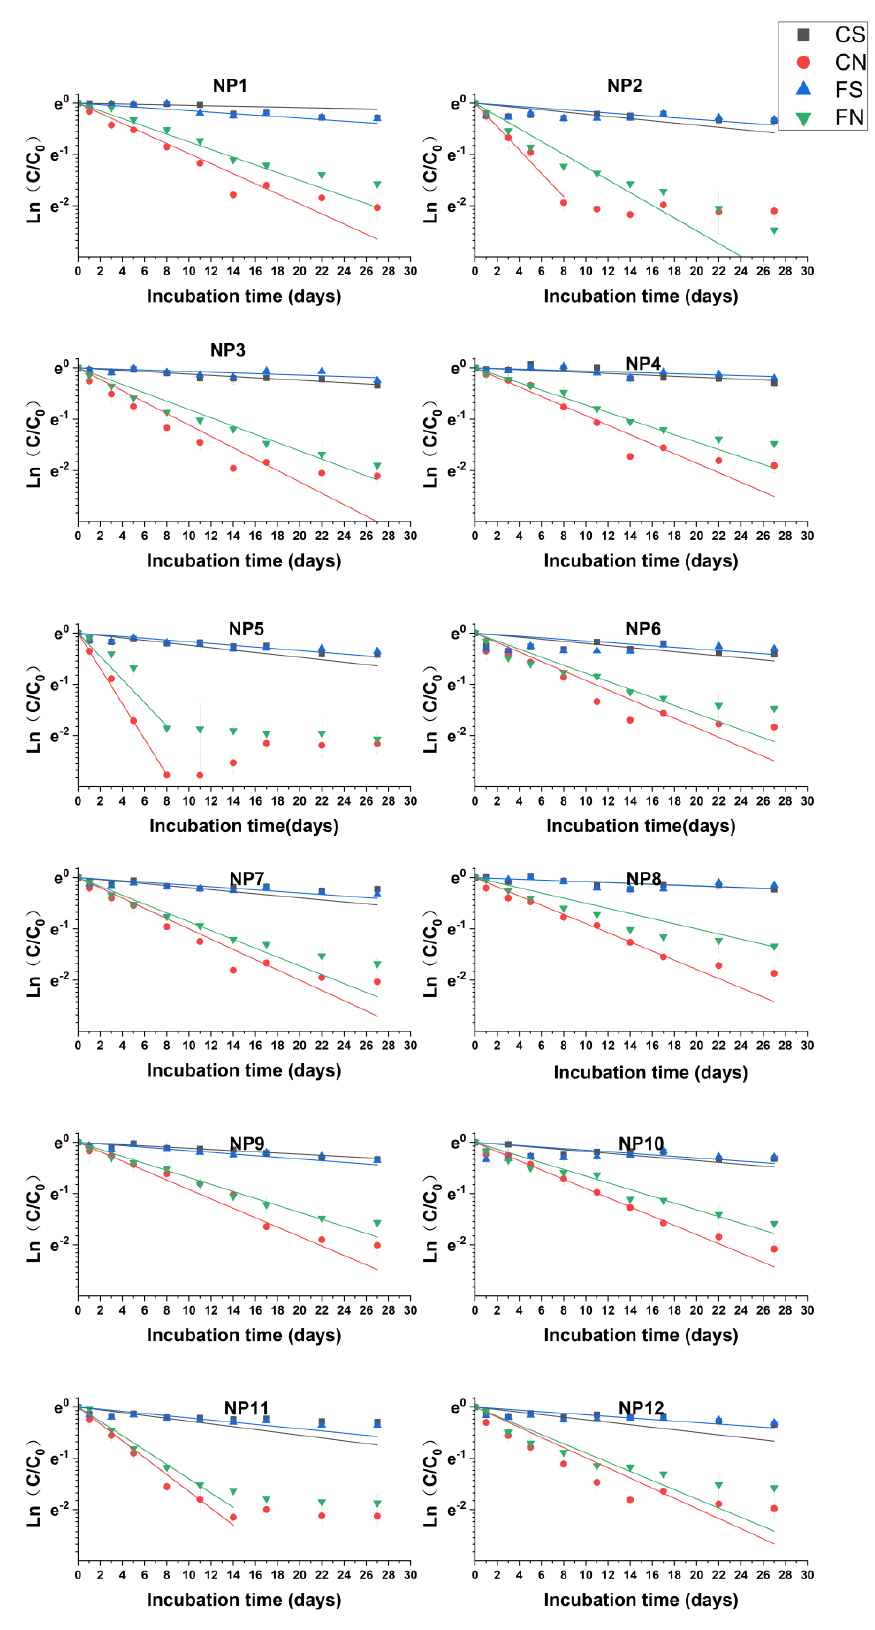
Figure 1. The degradation of isomers in Florida soil and China soil. Note: CN indicates the China soil with non-sterilization; CS indicates the China soil with sterilization; FN indicates the Florida soil with non-sterilization; FS indicates the Florida soil with